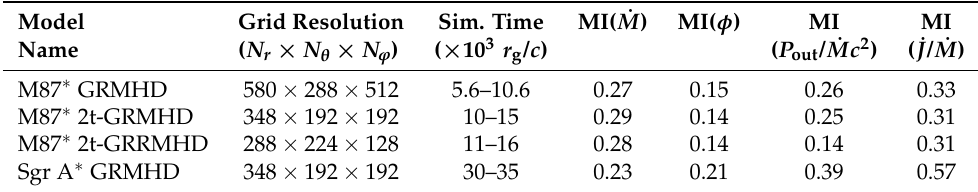
Figure 1. We show the mass accretion rate ˙ M , dimensionless magnetic flux φ ≡ Φ / efficiency P out / ˙ Mc 2 = 1 − ˙ E / ˙ Mc 2 , and specific radial flux of the angular momentum ˙ J / ˙ M over time. Values are calculated at the event horizon. Table 1. GRMHD simulations considered in this work. Simulation grid resolution, simulation time period over which raytracing was performed, modulation index (MI) of the mass accretion rate ˙ M , dimensionless magnetic flux φ , outflow efficiency P out / ˙ Mc 2 , and the specific angular momentum flux ˙ J / ˙ M for each GRMHD model. The MI is calculated over the final 5000 r g / c in runtime and at the event horizon (see Figure